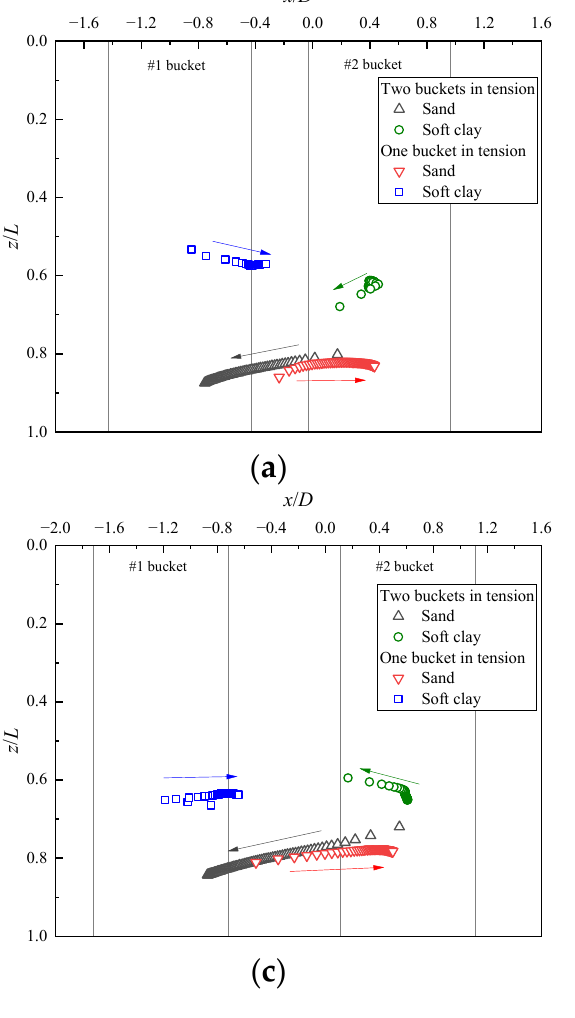
Figure 17. Trajectory of rotation center under overturning loading: ( a ) L / D = 0.75, ( b ) L / D = 1, ( c ) L / D = 1.25.